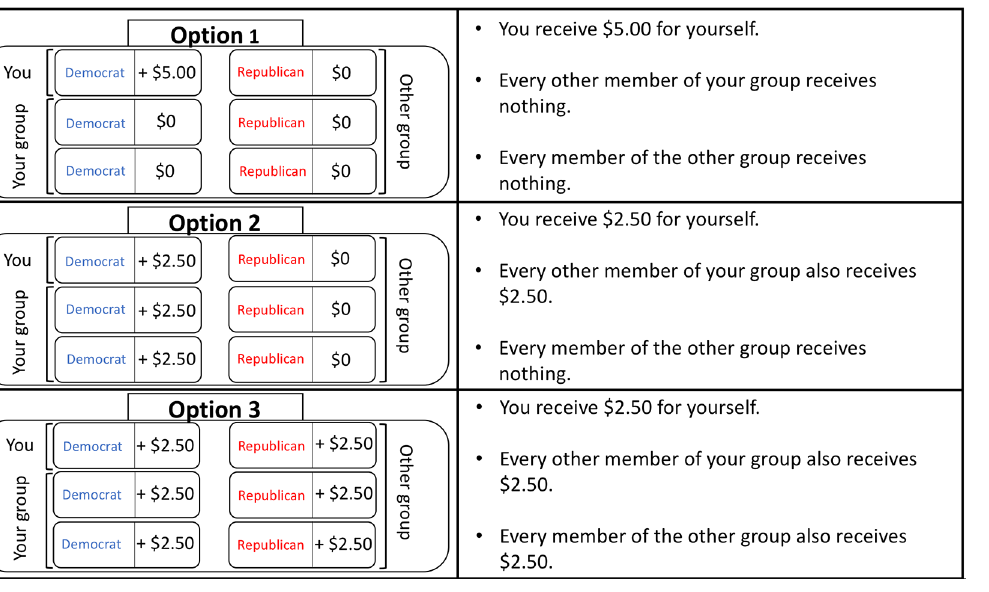
Figure 1. Decision options in the positive variant of the intergroup prisoner’s dilemma maximizing-difference game used in Studies 1 and